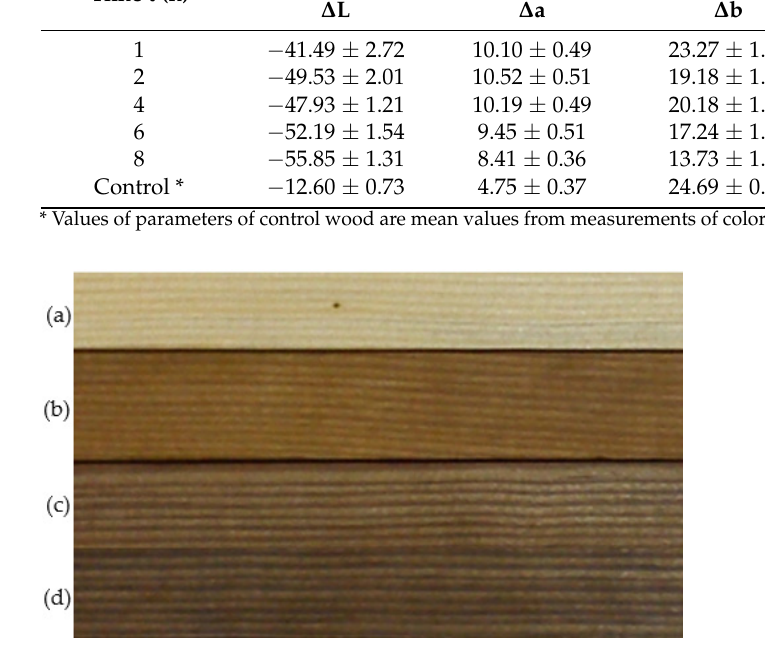
Figure 1. Sample surface—control ( a ) and heat-treated wood (constant temperature of heat treatment – 220 °C) at a heat treatment duration of 1 h ( b ); 2 h ( c ); 8 h ( d ). Table 1. Parameters of color change in heat-treated wood at different treatment time and at constant temperature.